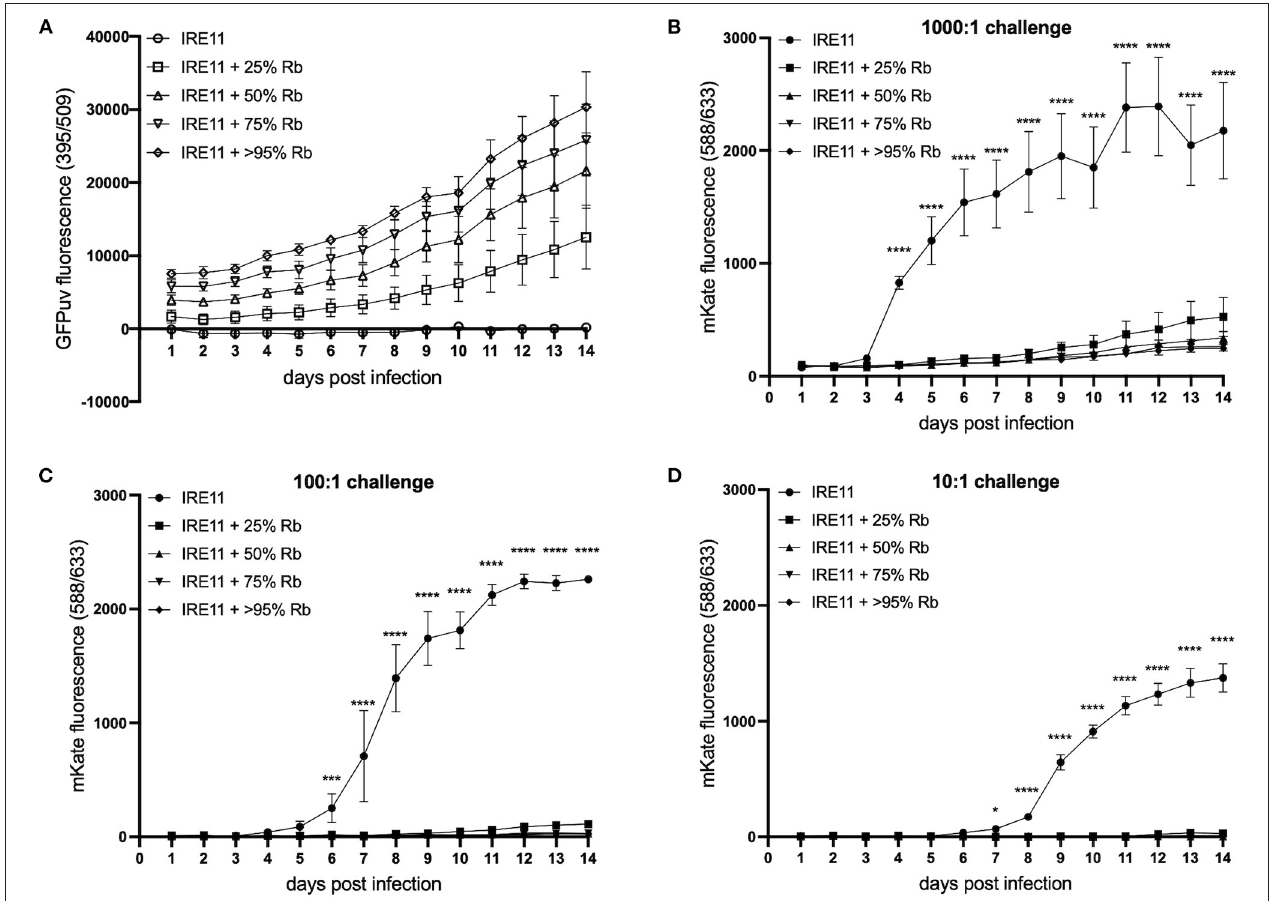
FIGURE 5 | Rickettsia buchneri prevents infection and replication of Rickettsia parkeri in tick cell culture. Uninfected IRE11 and IRE11 infected with different levels of R. buchneri- GFPuv were challenged with different doses of R. parkeri- mKate. Rickettsial replication in IRE11 cells was monitored for 14 days by measuring GFPuv and mKate fluorescence on a microplate reader. (A) GFPuv fluorescence indicating replication of R. buchneri- GFPuv. (B–D) mKate fluorescence indicating growth of R. parkeri- mKate at challenge doses of 1,000:1 (B) , 100:1 (C) , and 10:1 (D) ; lines show mean and error bars standard deviation of three replicate wells. Means were compared to the uninfected control IRE11 using a two-way ANOVA with Dunnett’s multiple-comparison test; statistically significant values are marked by asterisks * p < 0.05, *** p < 0.001, **** p < 0.0001. Data are representative of two independently performed experiments (see Supplementary Figure S4